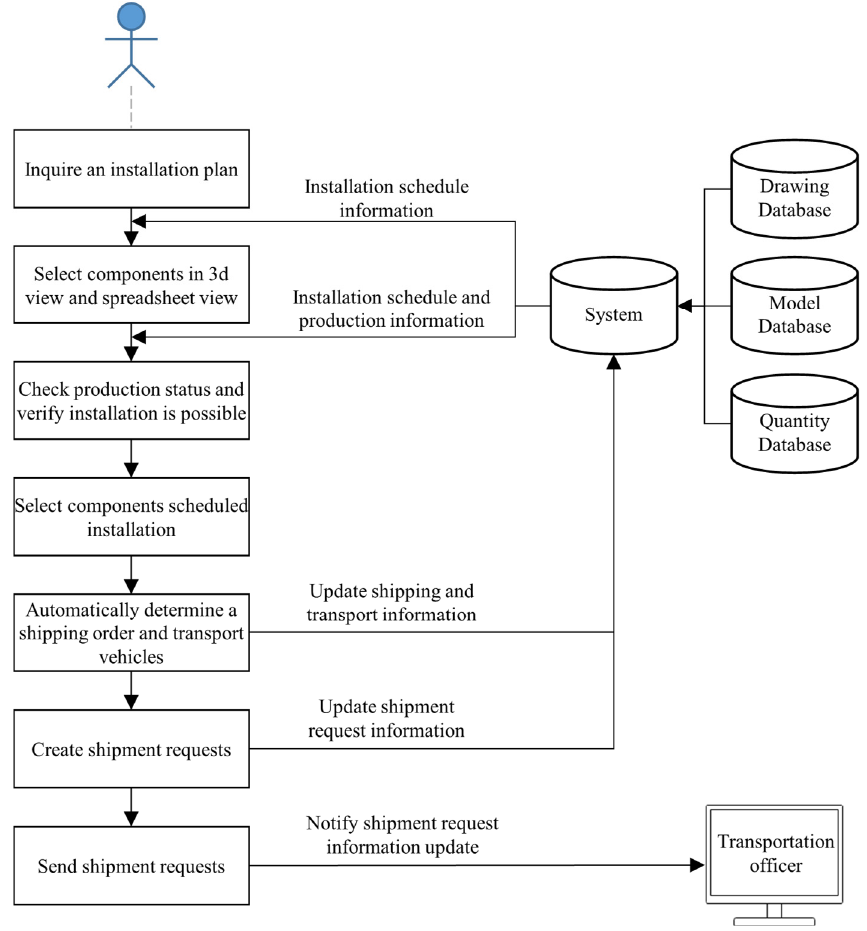
Figure 5. Flow chart for shipment request